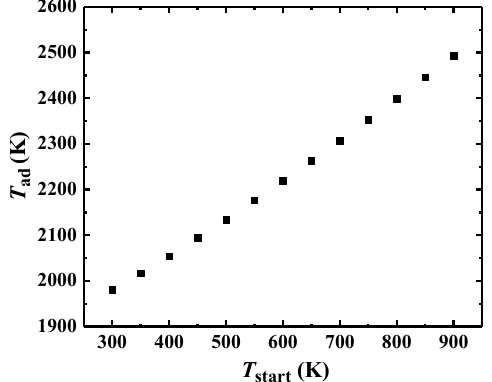
Fig. 8 T ad as a function of T start for Reaction (5) (Mo + Al + B = MoAlB).